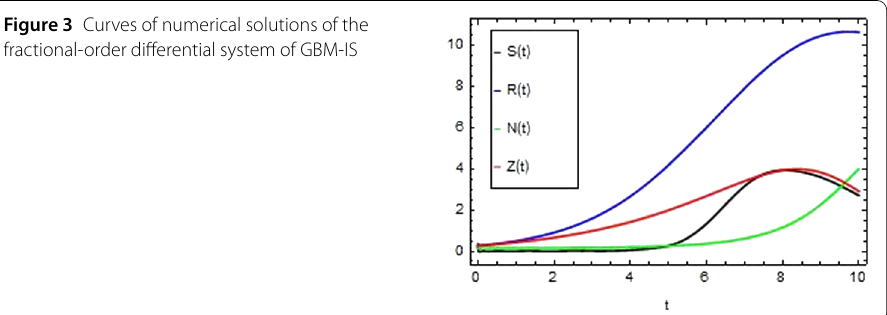
Figure 3 Curves of numerical solutions of the fractional-order differential system of